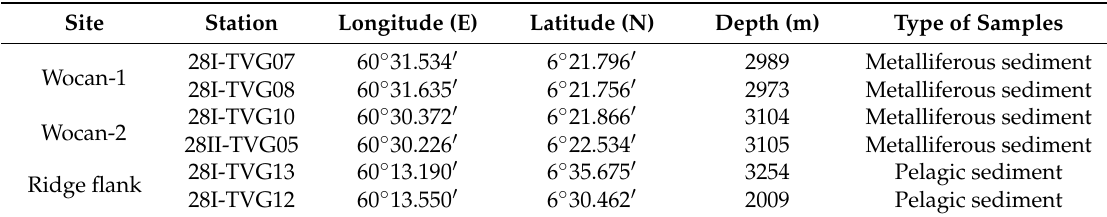
Table 1. The location and sampling information of studied sediment samples in